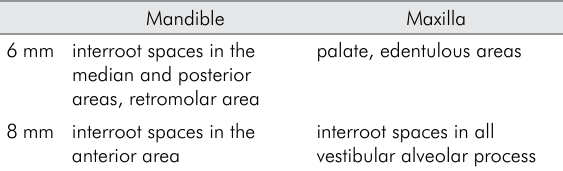
Table 2. Indication of MI’ length to be used in different sites in the maxilla and mandible, based on the cortical bone thickness.